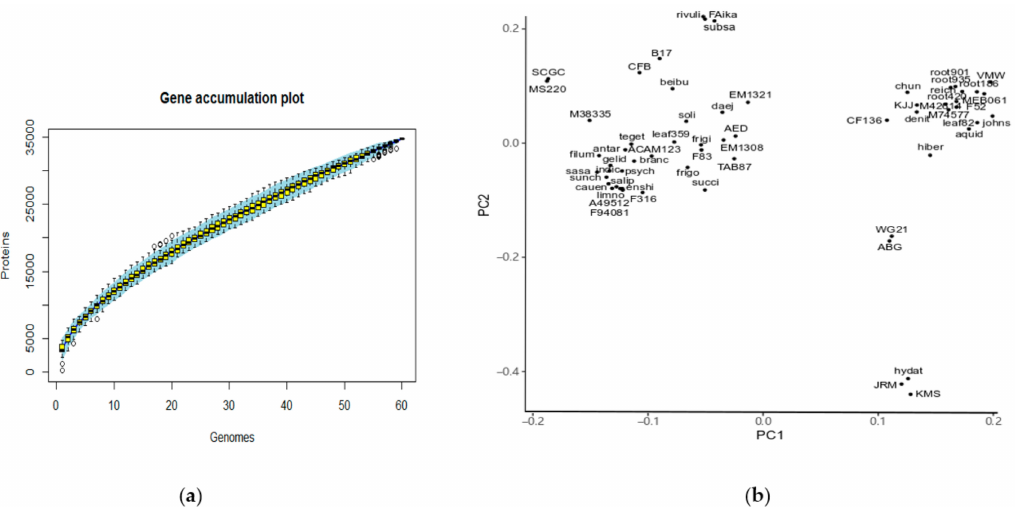
Figure 3. Pan-genome of Flavobacteria . ( a ) Gene accumulation plot of pan-genome of Flavobacteria . Each box represents the values for any possible combination of gene clusters in the respective number of genomes. ( b ) Two dimensional scatter plot based on the presence and absence of gene families in the Flavobacteria genus. The binary matrix representing the presence and absence of gene families was imported into the R program. IK-1 T showed close relationship to F. rivuli and F. subsaxonicum , and showed distinct distances to other species in the Flavobacterium genus. The percentages of PC1 and PC2 in Figure 3b are 15.95% and 4.88%,